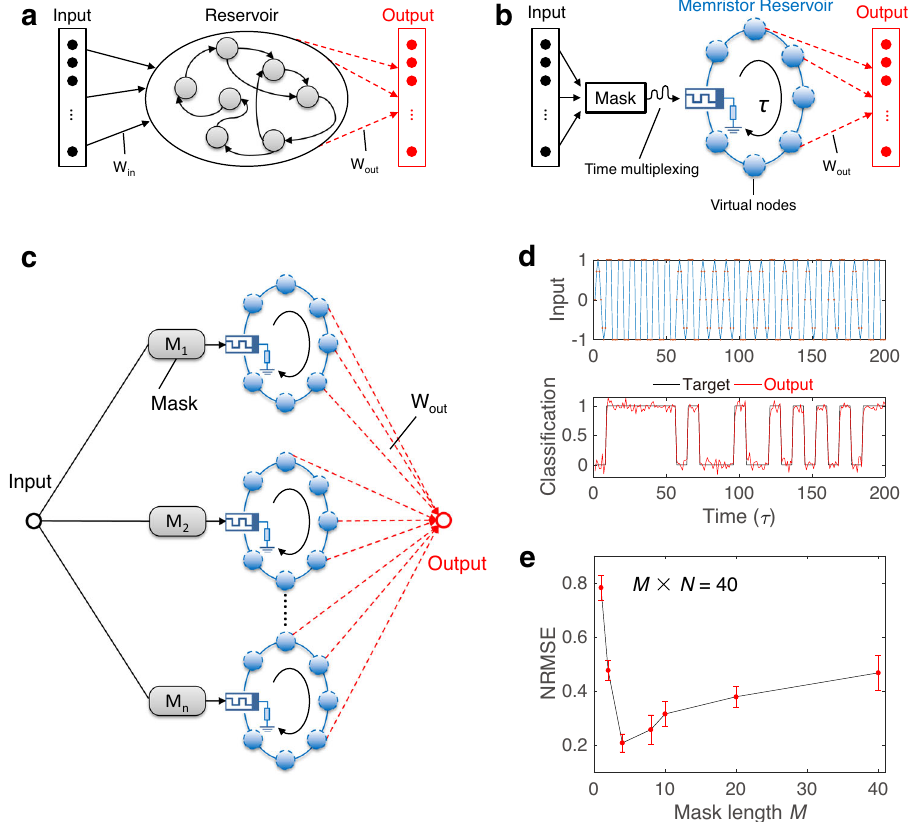
Fig. 2 RC system architecture and waveform classi fi cation demonstration. a Schematic of a conventional RC system. The input is fed to a reservoir, which is composed by a large number of nonlinear nodes. The internal connections among these nodes are random and fi xed. The correct output learns from the states of nodes by training the output weights. b Schematic of the dynamic memristor-based RC system. For a given input, the input vector is transformed into a temporal signal through a mask (that is the time multiplexing process) and then fed to the reservoir, which consists of a dynamic memristor and a load resistor in series. The memristor responses within a duration time τ are selected as the virtual nodes with a fi xed time step δ . The output vector is a linear combination of the values in the virtual nodes and the weights ( W out ) can be trained through linear regression. c Schematic of a dynamic memristor- based parallel RC system, where the mask sequences are different for every single memristor RC unit. The output is the linear combination of all reservoir states. In our experiment, this parallel RC system is realized by testing single memristor in multiple cycles. d The input and classi fi cation result of sine and square waves. The input sequence is a random combination of sine and square waveforms, where the sampling points for each waveform are set to 8. The optimal classi fi cation results are achieved when the length of mask sequence and the number of reservoirs in parallel are set to 4 and 10, respectively, and the lowest NRMSE we get is 0.14. e NRMSE changes with the mask length when keeping the reservoir size (that is the product of mask length M and number of reservoirs N ) the same. Ten different devices are tested and the average of NRMSE reaches the minimum value as the mask length reaches 4. The error bar shows the variation between